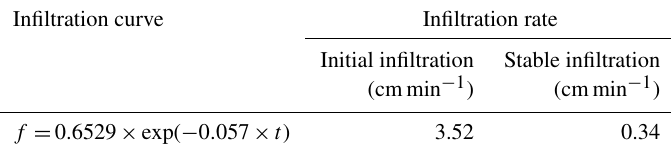
Table 2. The infiltration characteristics of solid materials in the study area. Infiltration curve